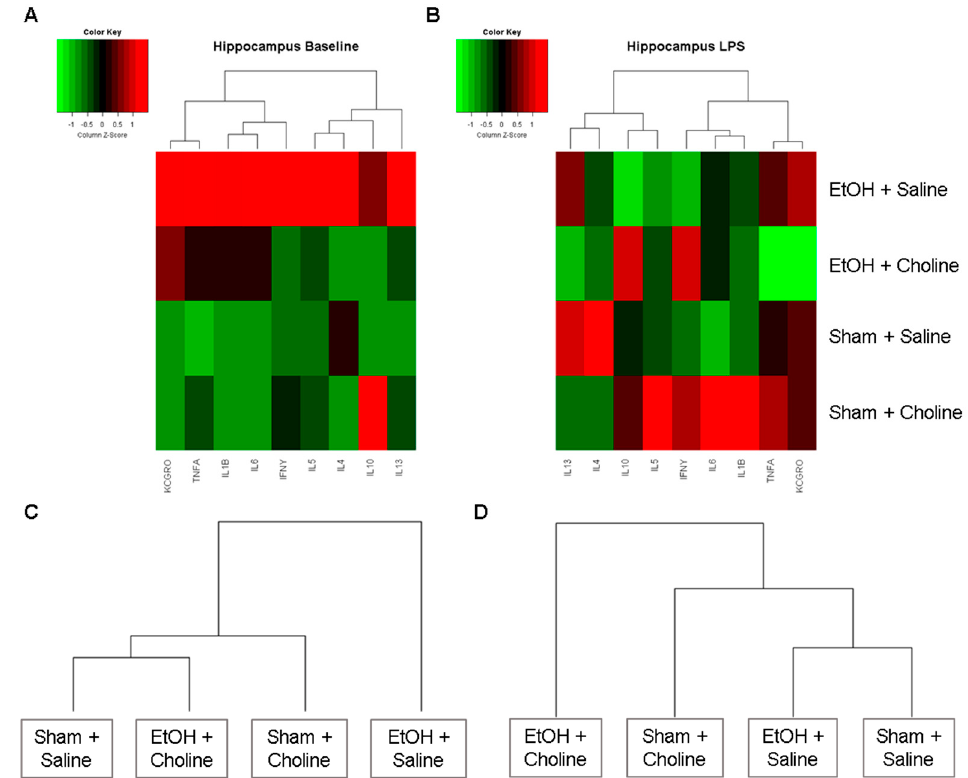
Figure 2. Overall hippocampal cytokine profiles. Heatmaps depicting overall cytokine profiles in the hippocampus in each group at ( A ) baseline and ( B ) after LPS immune challenge. Rows represent treatment groups and columns represent hierarchical clustering of mean cytokine levels (z-scored data). Additional dendrograms depict clustering of the treatment groups based on hippocampal cytokine profiles at ( C ) baseline and ( D ) after LPS immune